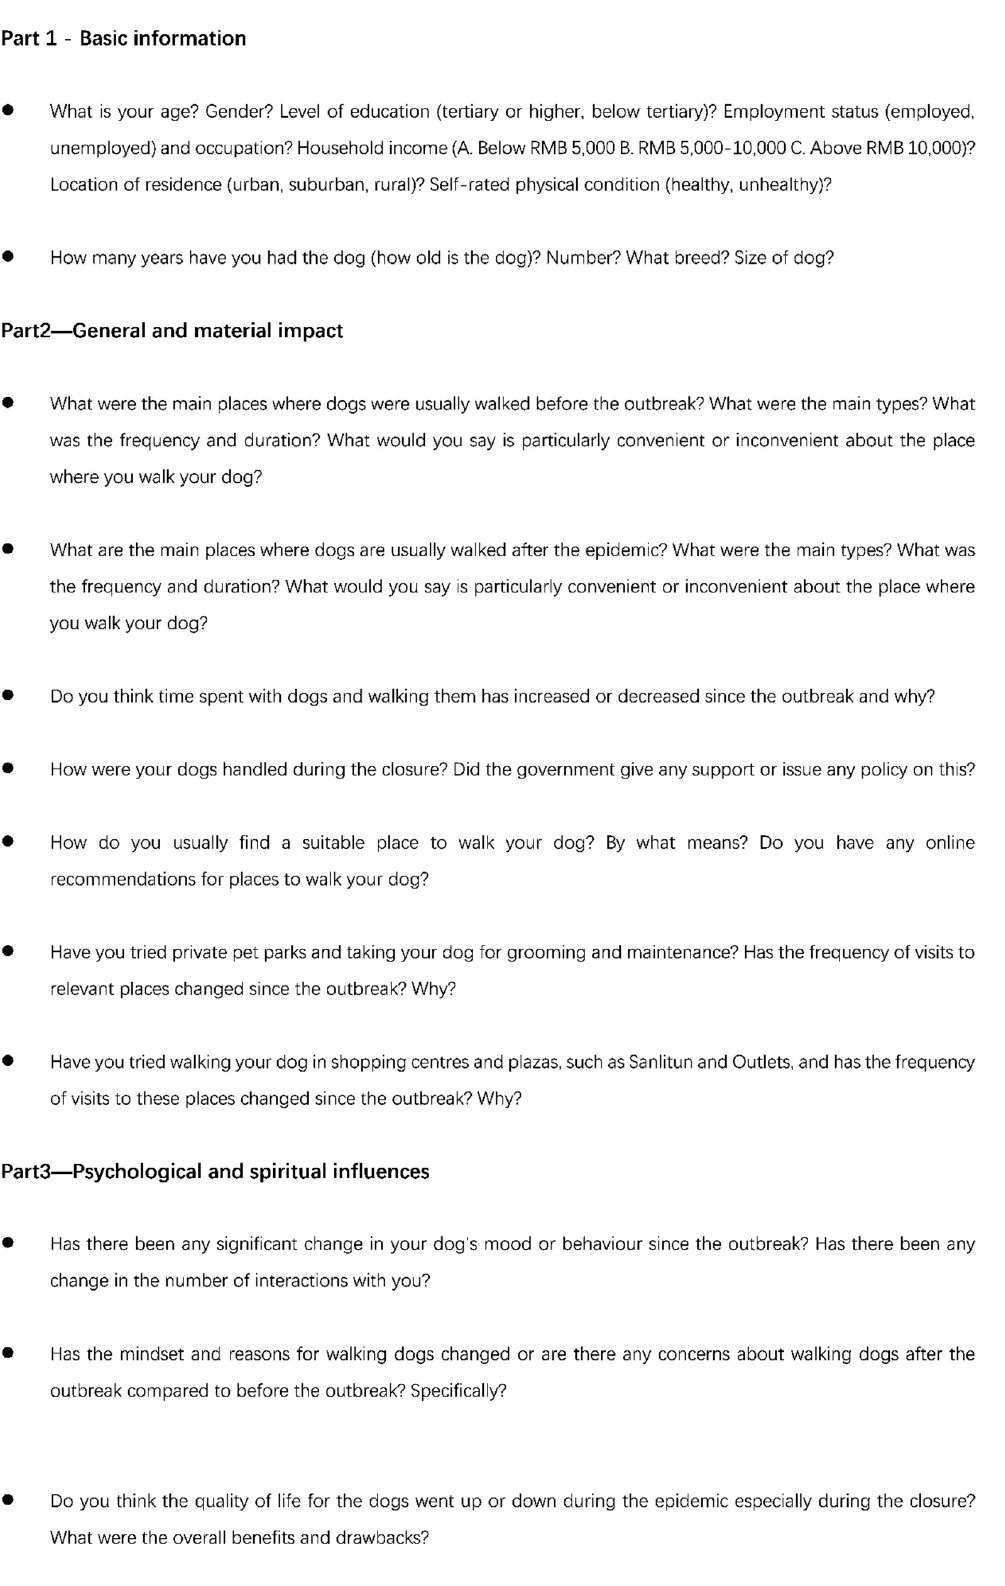
Figure A3. Broad question set for the semi-structured in-depth interviews.